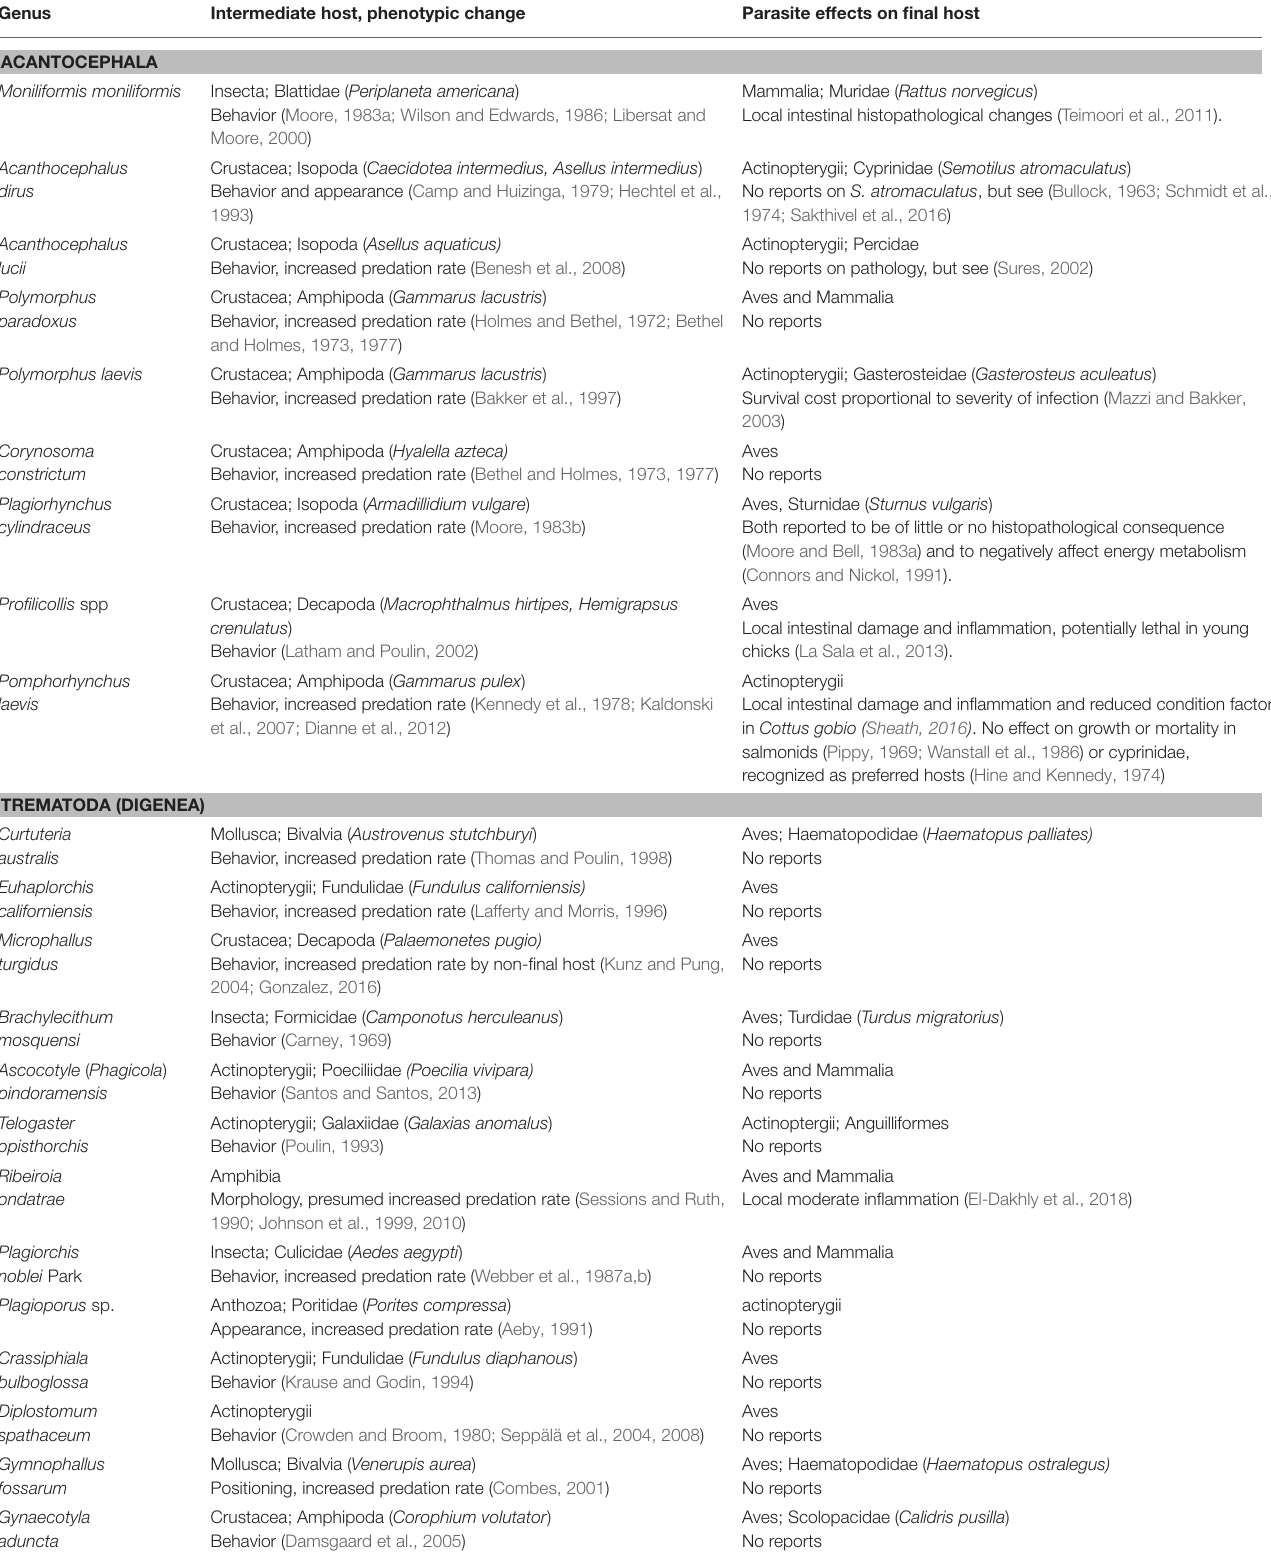
TABLE 1 | Parasites providing easy